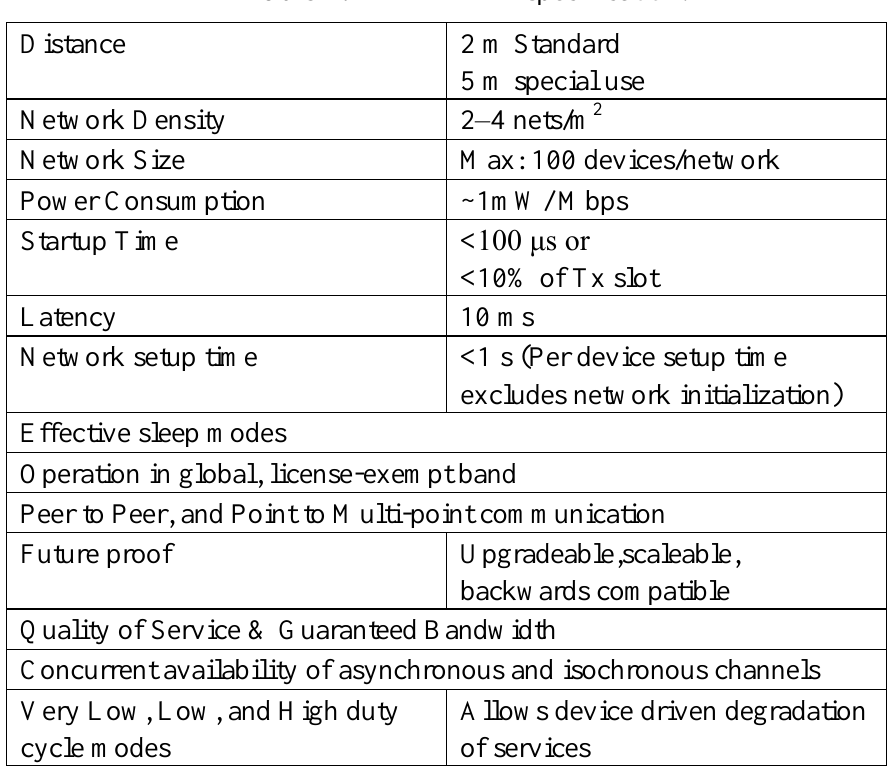
Table 1. IEEE WBAN